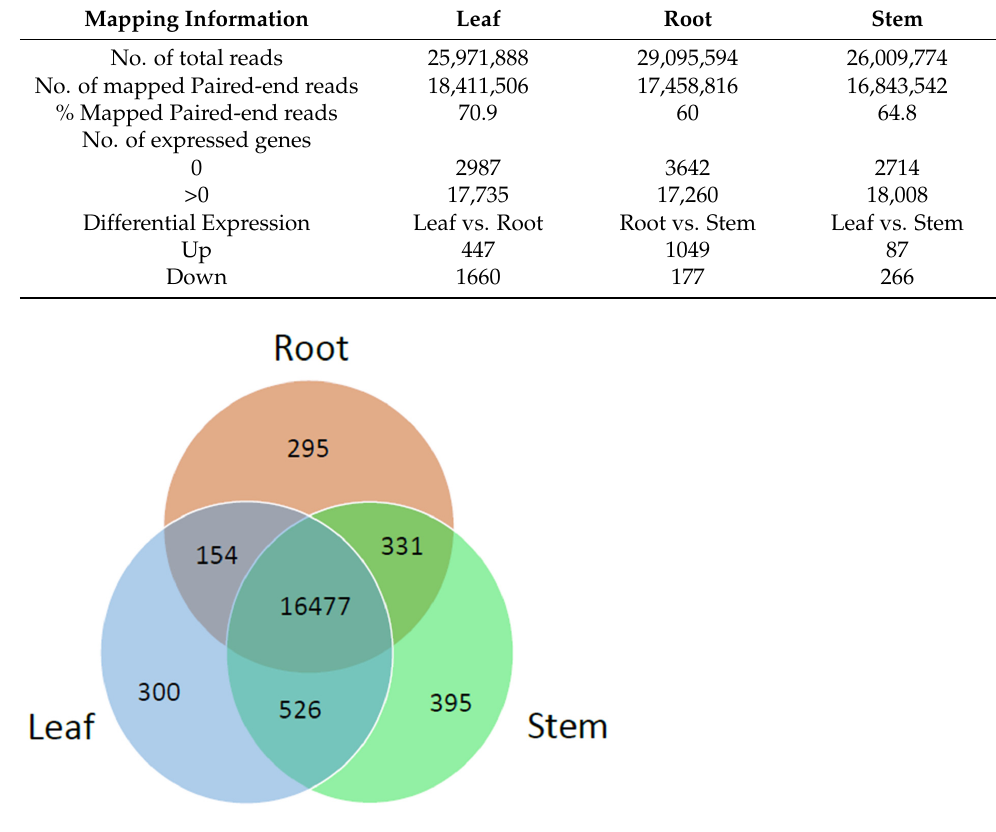
Figure 5. Venn diagram showing the number of unigenes expressed in three different organs.